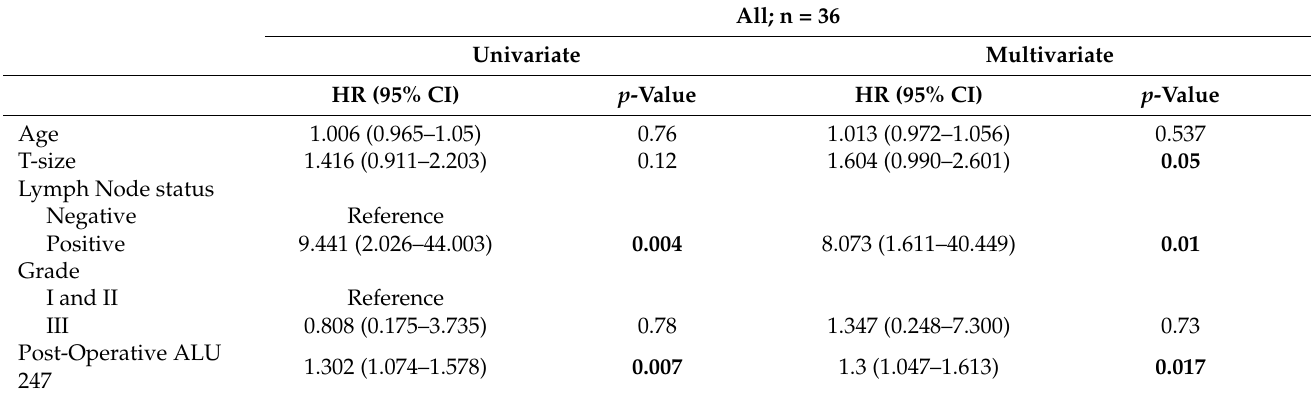
Table 2. Univariate and multivariate Cox proportional hazard analysis carried out to validate the prognostic importance of ALU 247 in comparison to other clinico-pathological characteristics.